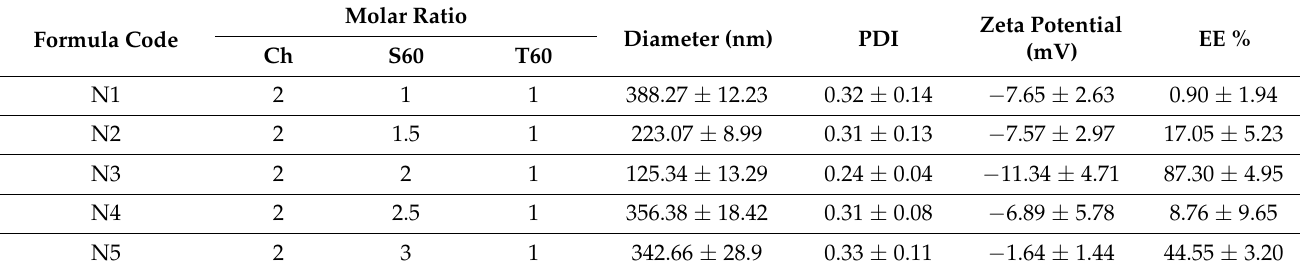
Table 2. The average particle size, PDI, ζ -potential, and EE% of different niosomal formulas. All experiments were conducted in triplicate, and the results were expressed as means ± standard